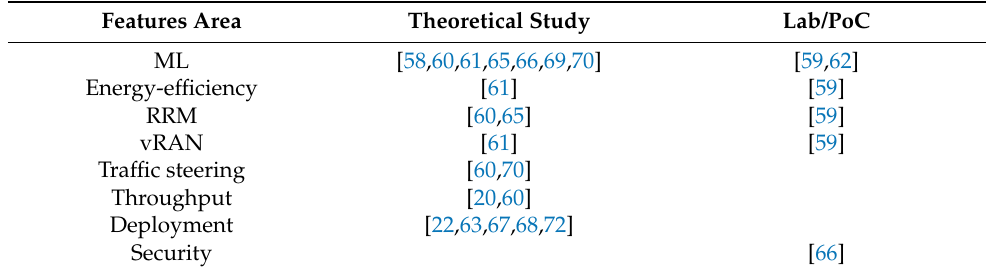
Table 4. Open RAN features area covered by research